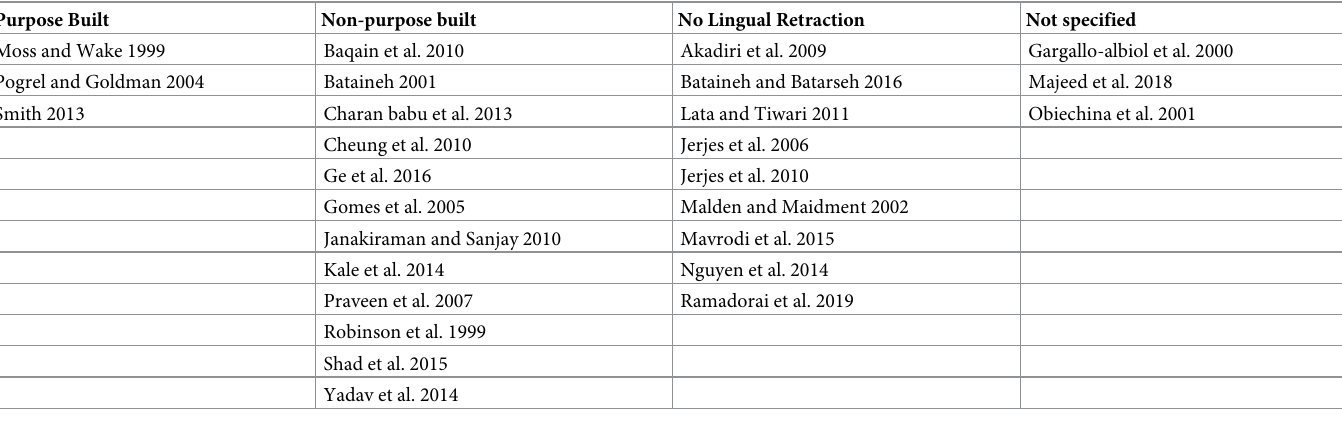
Table 2. Different types of lingual retractors used in M3M